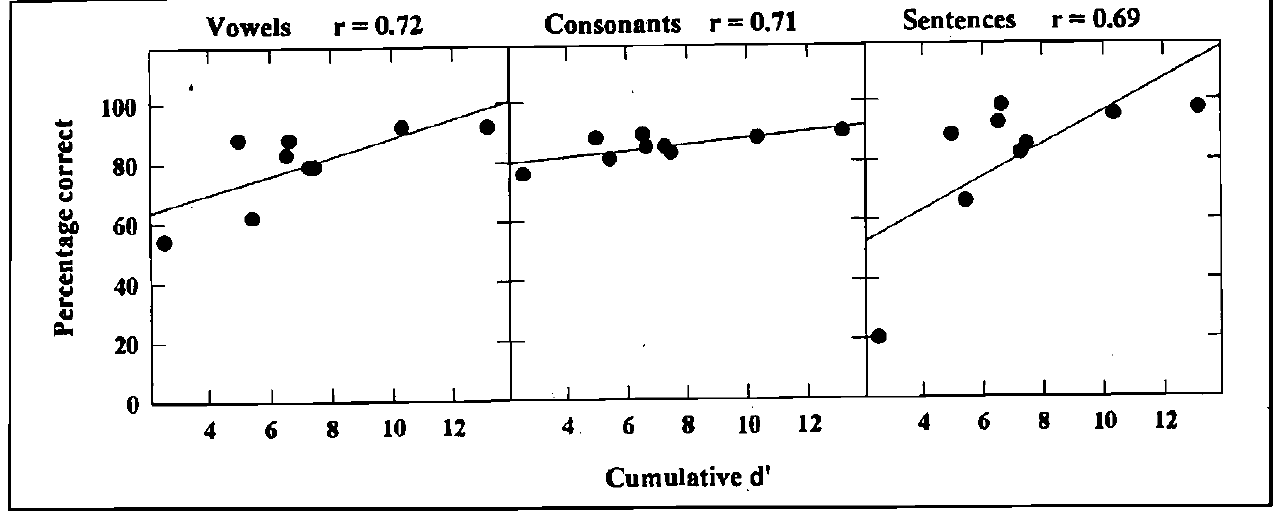
FIGURE 5. Speech perception as a function of cumulative d' for subject JEM. Regression lines for linear regression are fitted through the data. The jcorrelation coefficients are shown above each panel. Although the correlation coefficients are significant for all three speech perception performance measures, the slope was shallow for the consonant test.